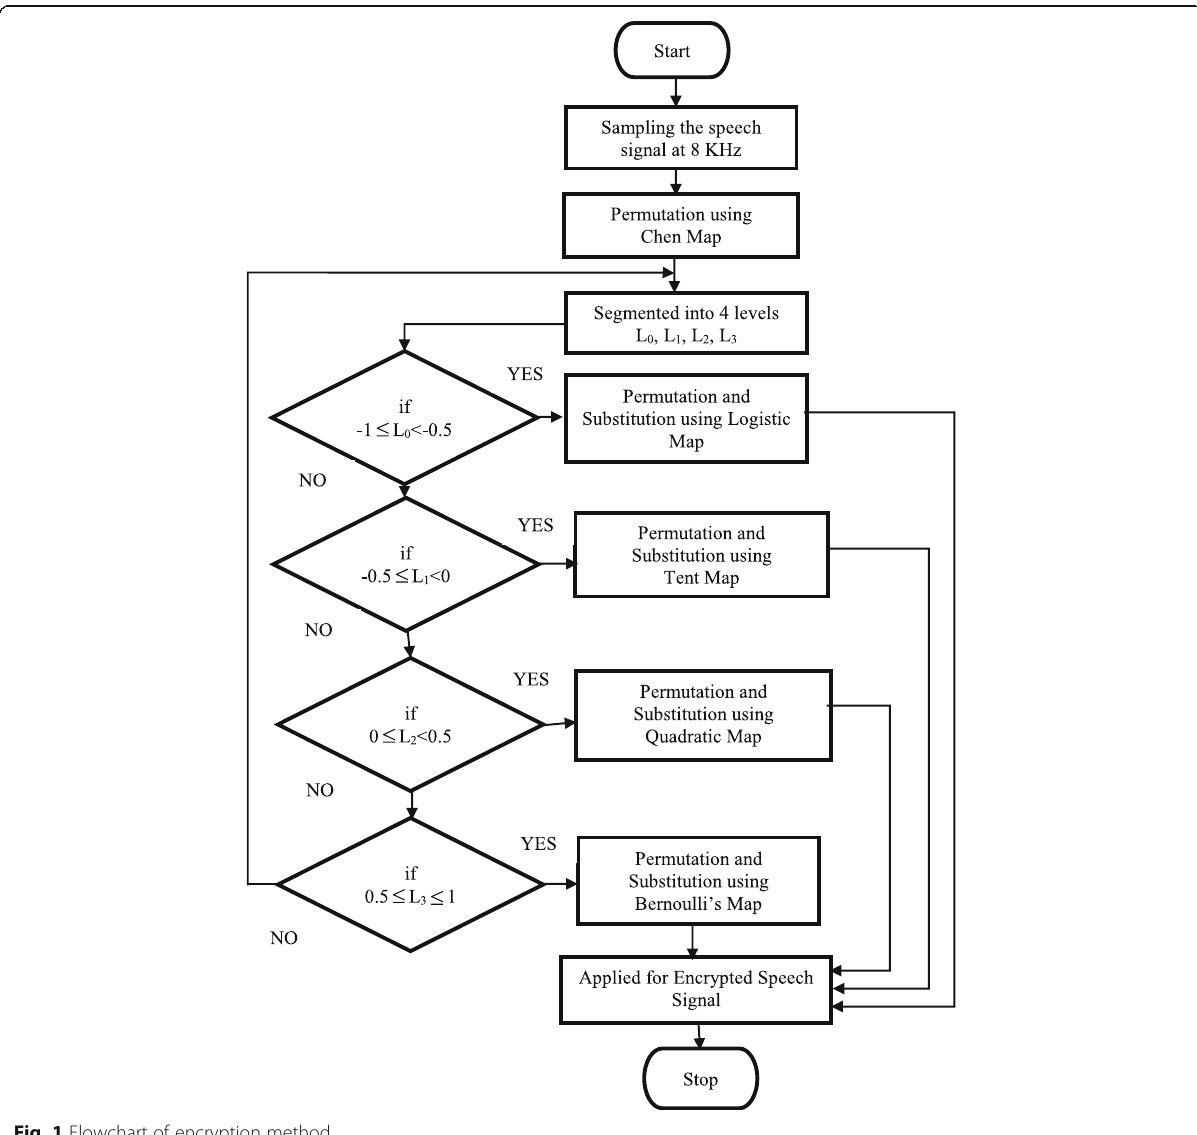
Fig. 1 Flowchart of encryption